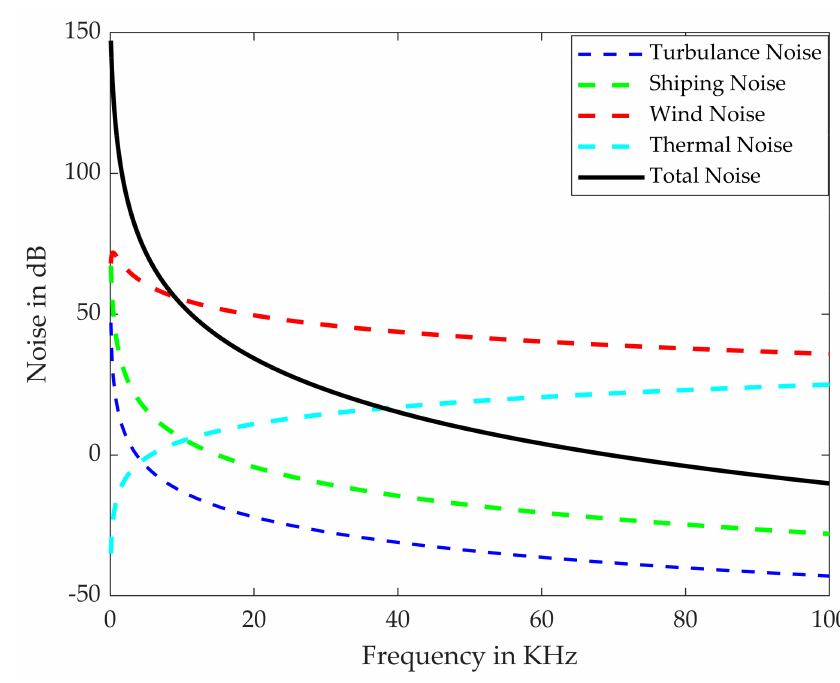
Figure 15. Different noise variances in